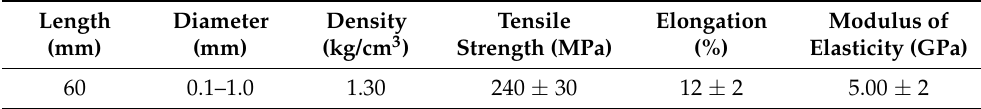
Figure 1. Date palm fibers as an agro-waste material. Table 3. Physical properties of date palm fibers [35]. Table 3. Physical properties of date palm fibers [35].